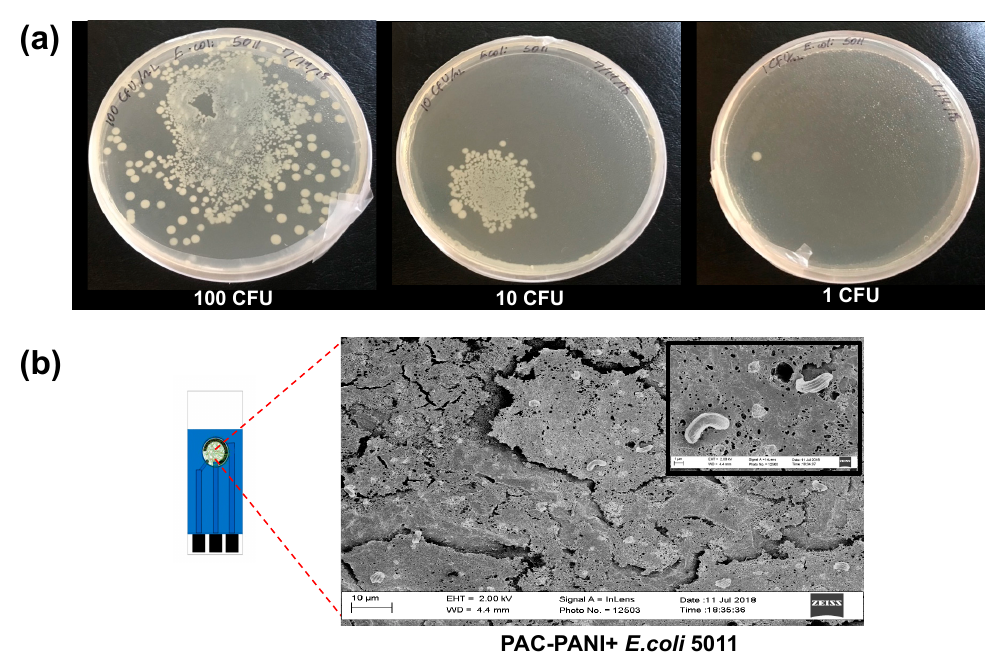
Figure 9. ( a ) Plate culturing of the ExPEC at 100, 10, and 1 CFU/mL loads. ( b ) SEM micrograph showing the adhesion ExPEC on the functionalized surface of the working electrode of PAC-PANI/SPE after successive washings with PBS.